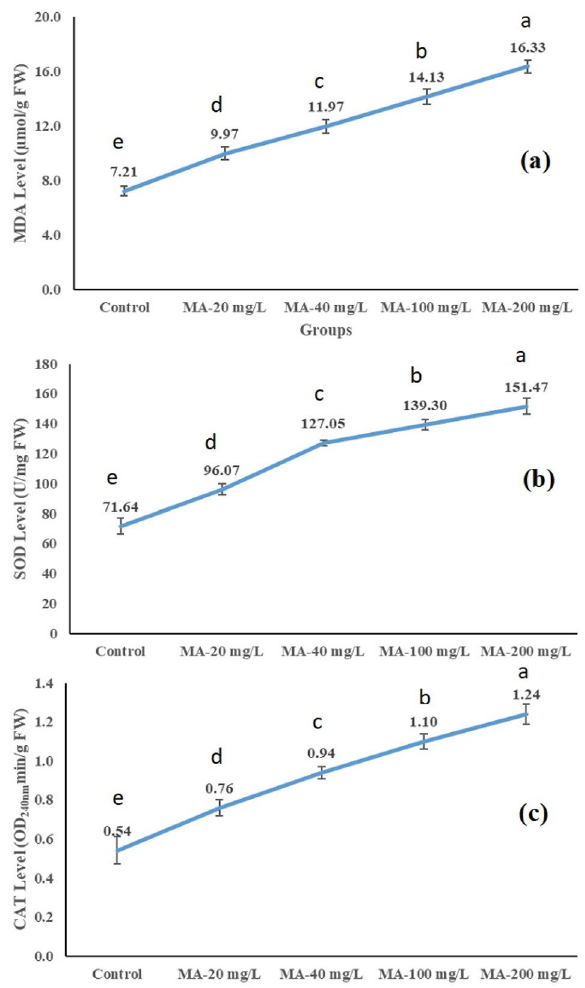
Figure 3. The effect of metaldehyde treatments on biochemical parameters.